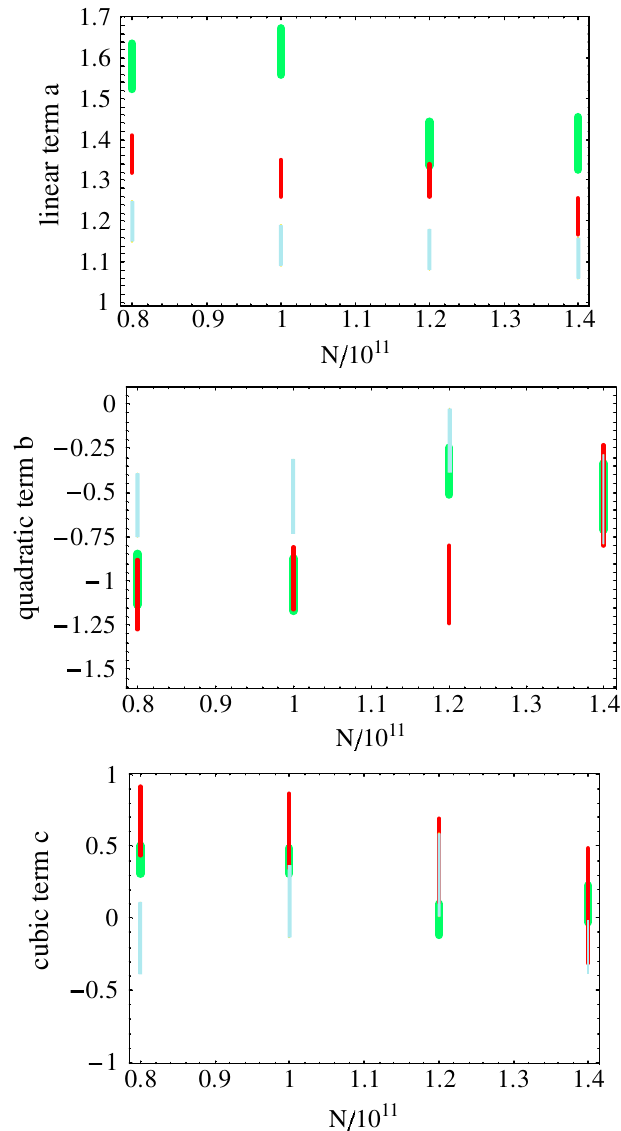
FIG. 3. (Color) The a , b , c coefficients obtained by fitting the map (1) to the density buildup regime, for several N . The bars (cid:5) 1 : 3 (cyan), represent the 95% confidence intervals for (cid:1) max (cid:5) 1 : 5 (red), and (cid:1) (cid:5) 1 : 7 (green). All other parameters (cid:1) max max as in Table